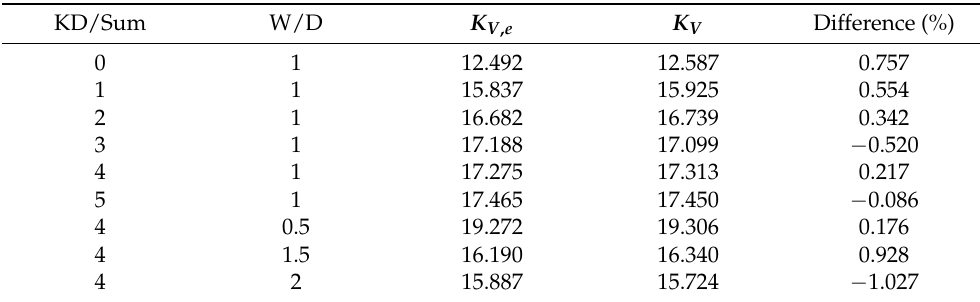
Table 8. Comparison between the vertical stiffness coefficients of a spudcan embedded in pure elastic and elastic perfectly plastic soil.